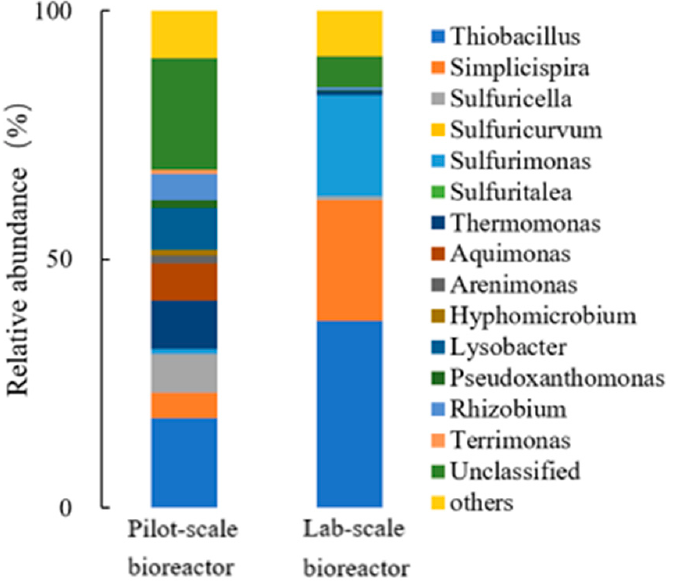
Figure 15. Microbial community structure at the genus level in the lab-scale and pilot-scale bioreactor. To clarify the flora succession of the microbial community on the sulfur particle bed at different heights, the upper (at 1.6–1.8 m), middle (at 1.1–1.3 m), and lower (at 0.6–0.8 m) sulfur particle bed of the pilot-scale bioreactor were sampled to be analyzed (Figure 16).